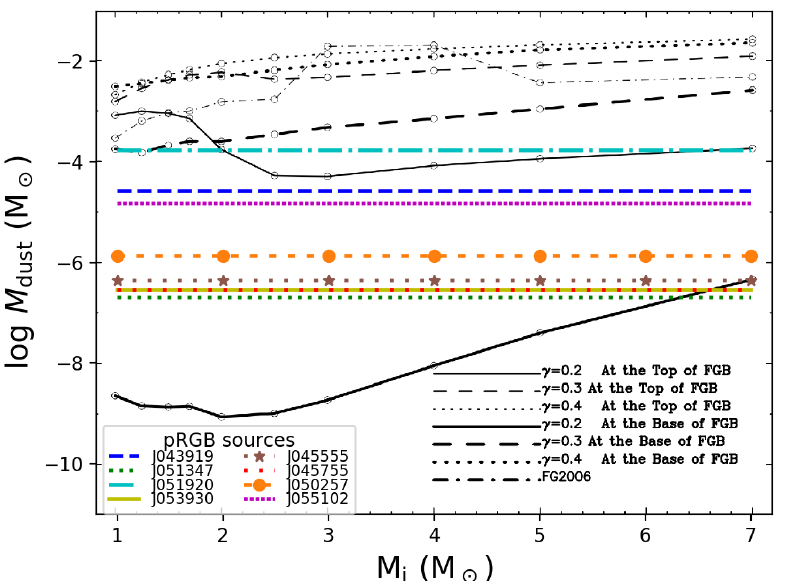
Figure 4. The dust mass in the outer shell of our post-RGB objects, M d (Table1) are shown (horizontal lines) on a plot of theoretically estimated dust masses in the ejecta of common envelope systems versus initial stellar mass, taken from Figure 2 of Lü et al. [34]. FGB refers to the first red giant branch. FG2006 refers to results by Ferrarotti & Gail [35], showing the dust masses produced in the dust-driven outflows of AGB